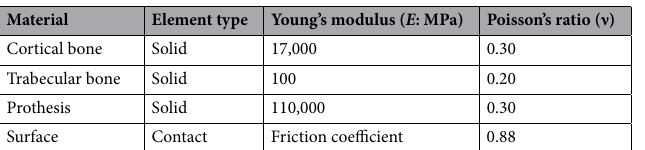
Table 1. Element types and material properties reported in the literature 17,18,23,24